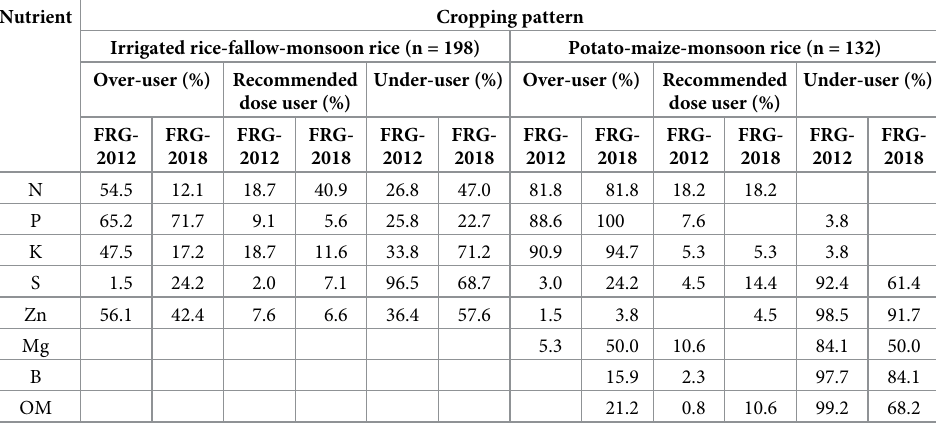
Note: OM indicates organic manure. For calculating nutrient use gaps of each nutrient relative to the recommended dose, total use rates of each nutrient in all crops in the cropping pattern were subtracted from total recommended rates. Here, ± 5% deviation of nutrient use from recommended nutrient dose in the cropping season was treated as a recommended dose